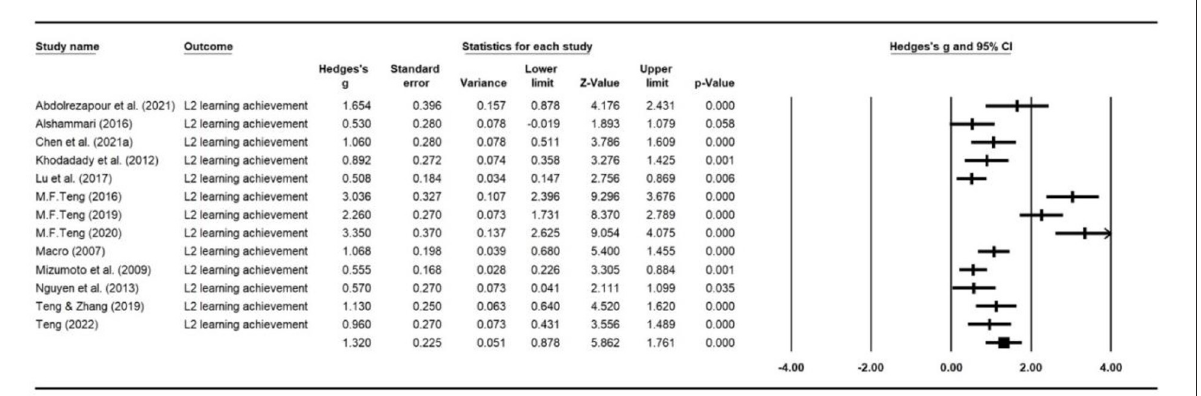
FIGURE6 Forest plot of overall effect size estimates for L2 learning achievement.